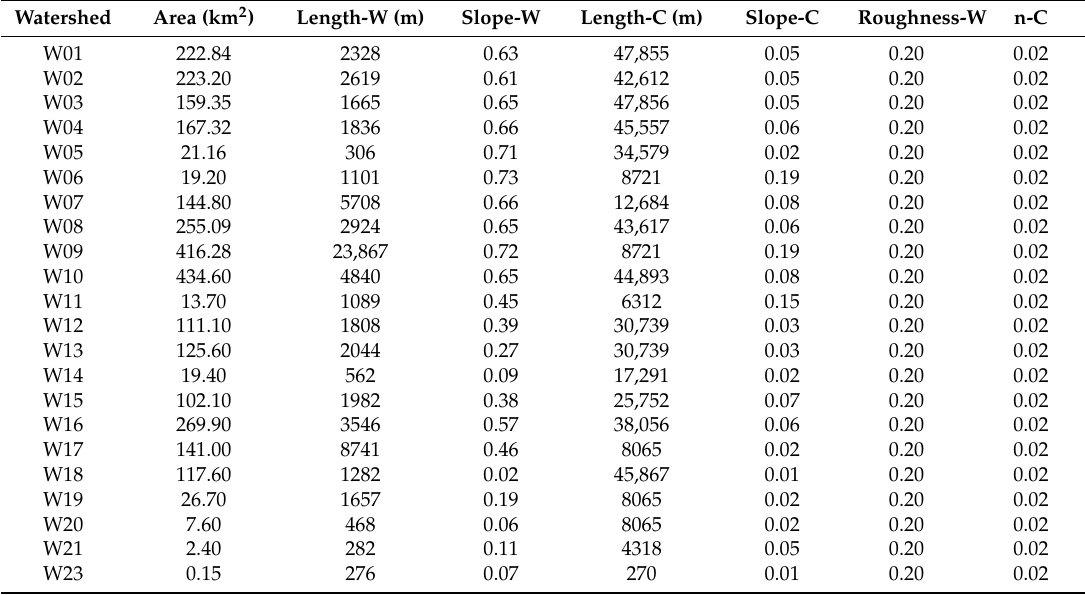
Table 7. Parameters for HEC-1 model.